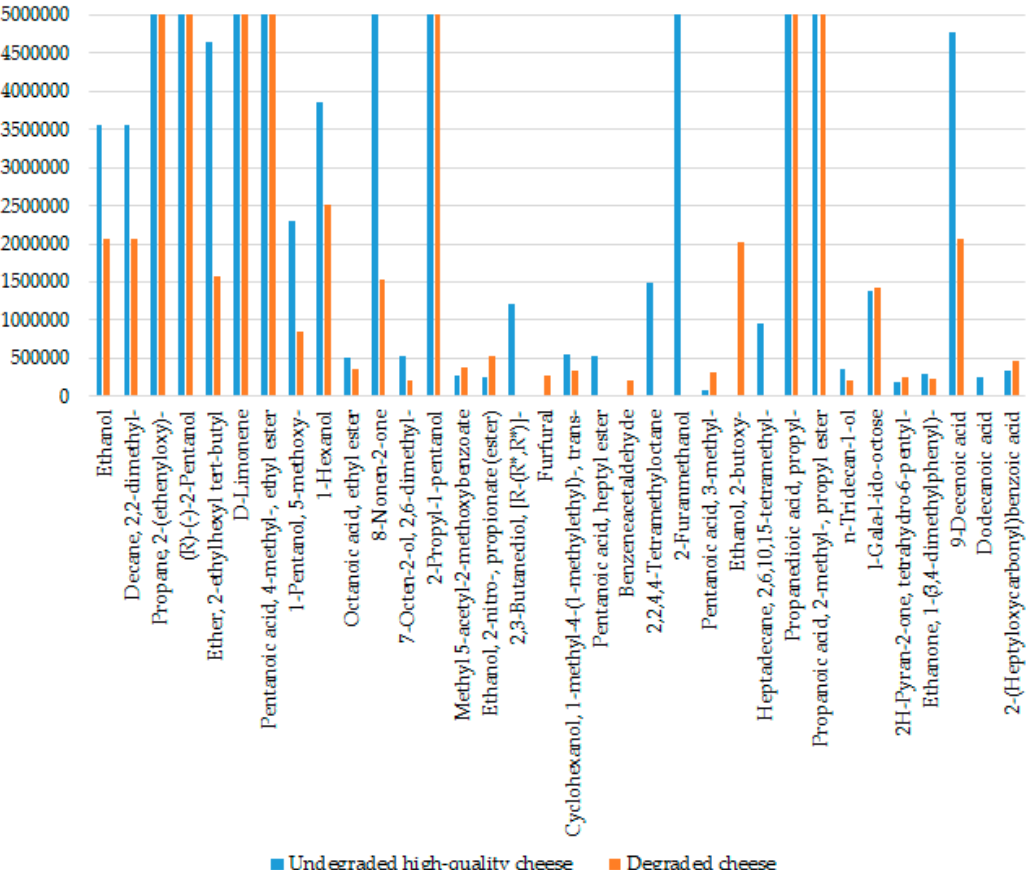
Figure 7. A histogram representing the VOCs from an undegraded high-quality cheese sample (blue) and a degraded Parmigiano Reggiano cheese sample (orange) identified by SPME-GC-MS analysis.